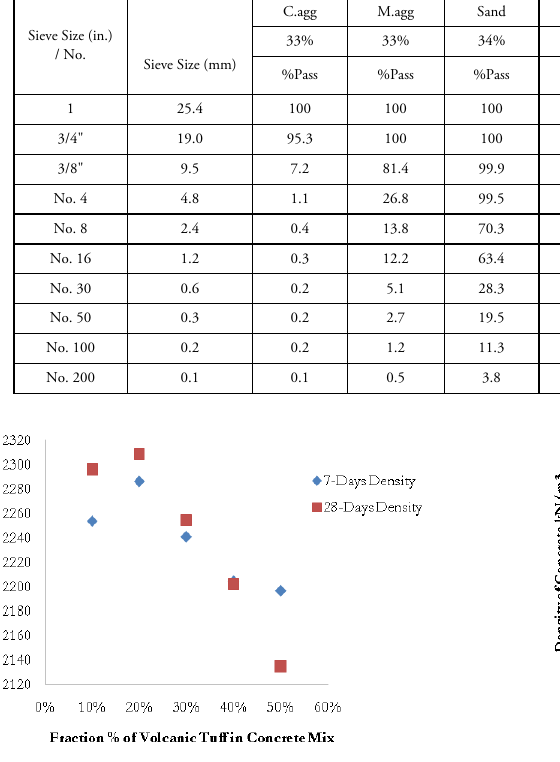
T ABLE 3: S IEVE A NALYSIS FOR C ONTROL C ONCRETE S AMPLE AND V OLCANIC T UFF C ONCRETE S AMPLES Sieve Size (in.) / No.